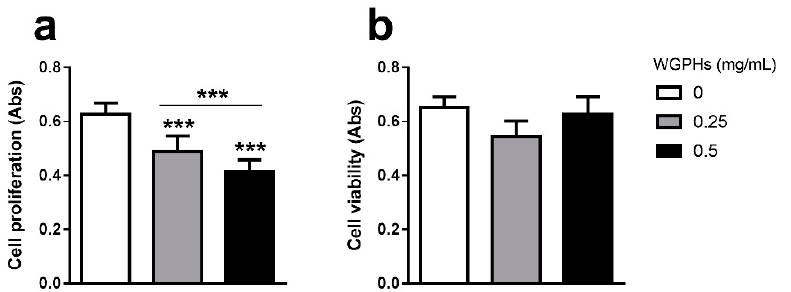
Figure 2. ( a ) Cell proliferation in phytohaemagglutinin-P (PHA)-stimulated cells incubated for 72 h with WGPHs (0, 0.25, and 0.5 mg / mL). ( b ) Cell viability in non-stimulated peripheral blood mononuclear cells (PBMCs) cultured for 72 h with WGPHs (0, 0.25, and 0.5 mg / mL). The data represent the mean and standard error of the mean ( n = 25). *** p ≤ 0.001.